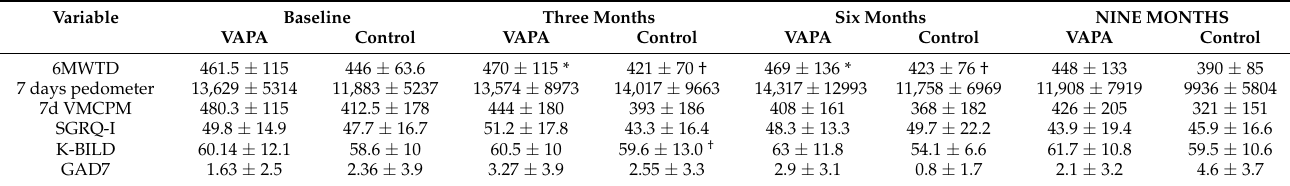
Table 3. Changes in primary and secondary endpoints within groups over time.